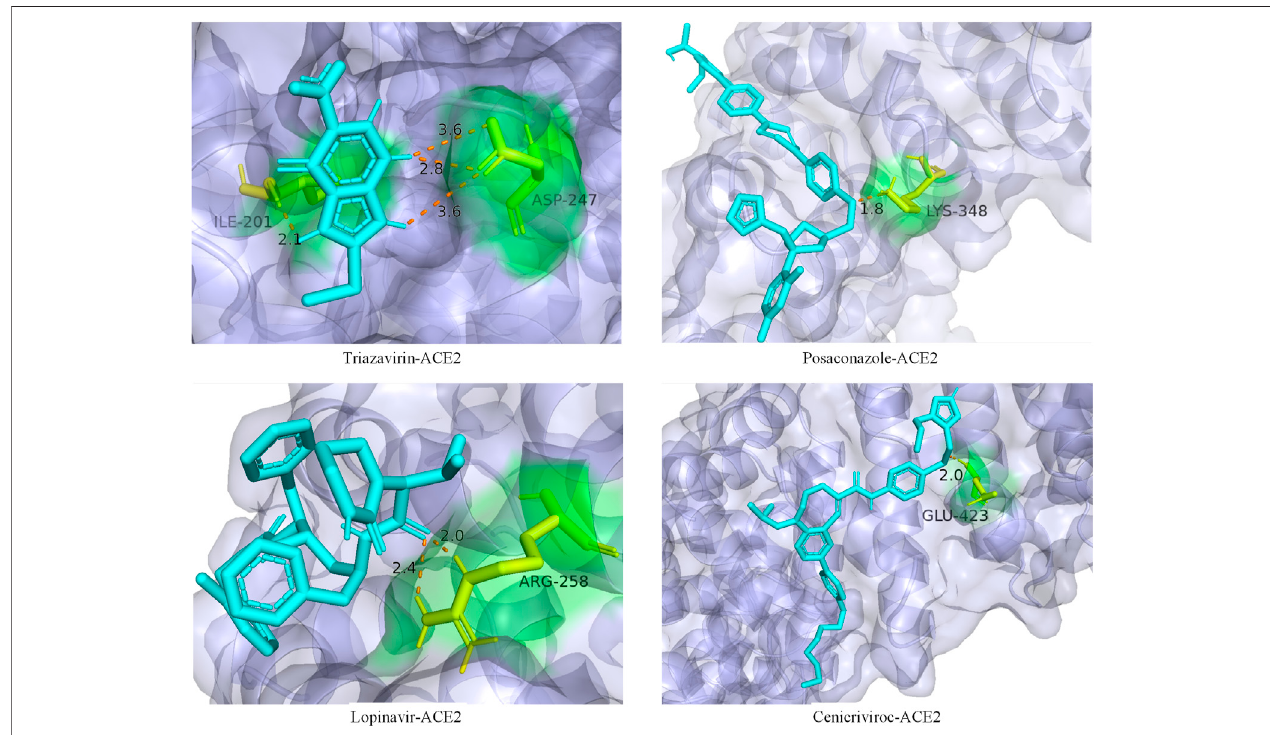
FIGURE 6 | Ligand – protein binding mode between the predicted drugs and the protein receptor ACE2. The purple part is the protein ACE2, the blue part is the drug compound, the yellow part is the amino acid residue, and the orange dotted line is the connecting hydrogen bond. The numbers represent atomic